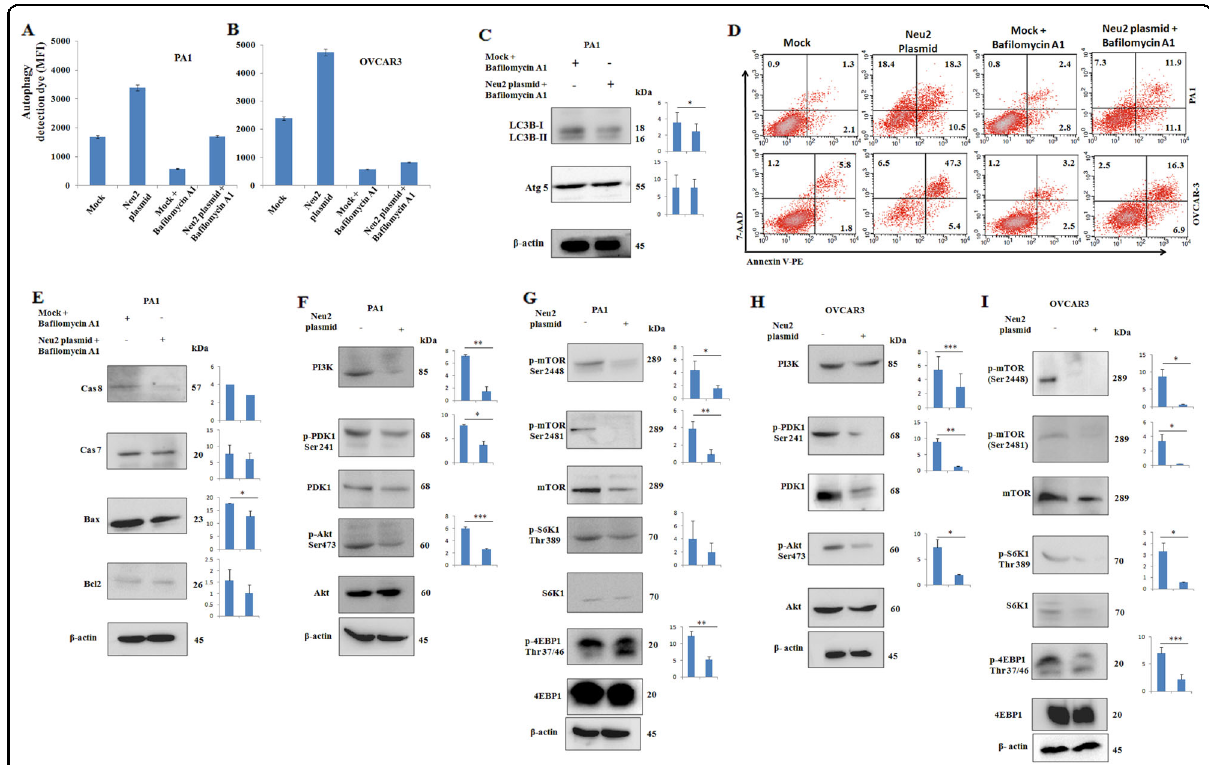
Fig. 5 Neu2-enhanced autophagy leads to apoptosis via inhibiting PI3K-Akt/mTOR signaling pathway in OC cells. A , B PA1 and OVCAR3 cells were initially pretreated with ba fi lomycin A1 followed by Neu2 transfection in the presence of ba fi lomycin A1 for 24 h as described in “ Methods. ” Cells were stained with autophagy detection dye and analyzed by FACS; MFI presented as a bar graph for comparison. C LC3B and Atg5 levels were compared in treated cells (PA1) by western blot. β -Actin was used as a loading control. D These treated cells were stained with PE-Annexin-V/7AAD and analyzed by FACS. Percent of early and late apoptosis are indicated for comparison . E Western blots showed the differences in protein levels of apoptotic-related molecules (caspase8, 7, Bax, and Bcl2) in ba fi lomycin A1-treated mock and Neu2-overexpressing cells. F – I The protein levels of different PI3K-Akt/mTOR molecules were compared in mock and Neu2-transfected PA1 ( F , G ) and OVCAR3 ( H , I ) by western blot. β -Actin was used as a loading control. The results are represented as mean ± SD from independent experiments and p values (* p < 0.05; ** p < 0.01; *** p < 0.001; two- tailed t test) represented the signi fi cant differences between the means of the two test